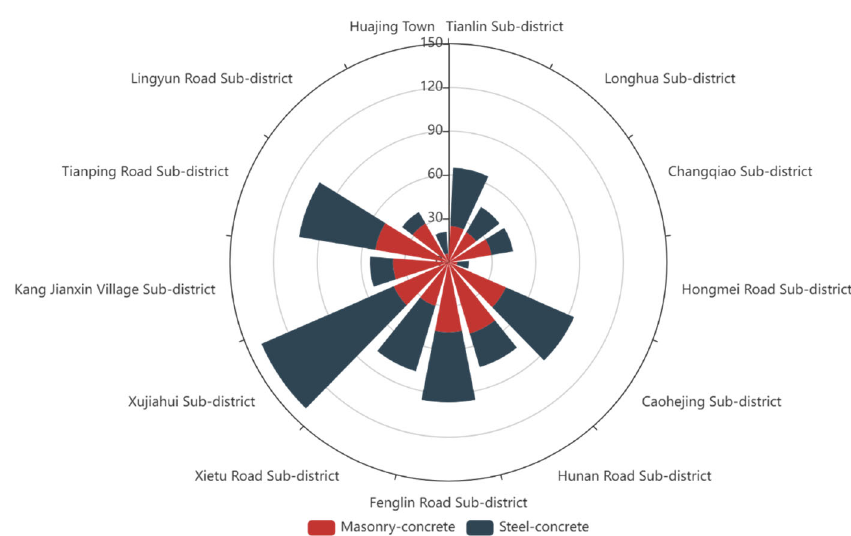
Figure 6. Structure type distribution in the sub ‐ districts of Xuhui District.